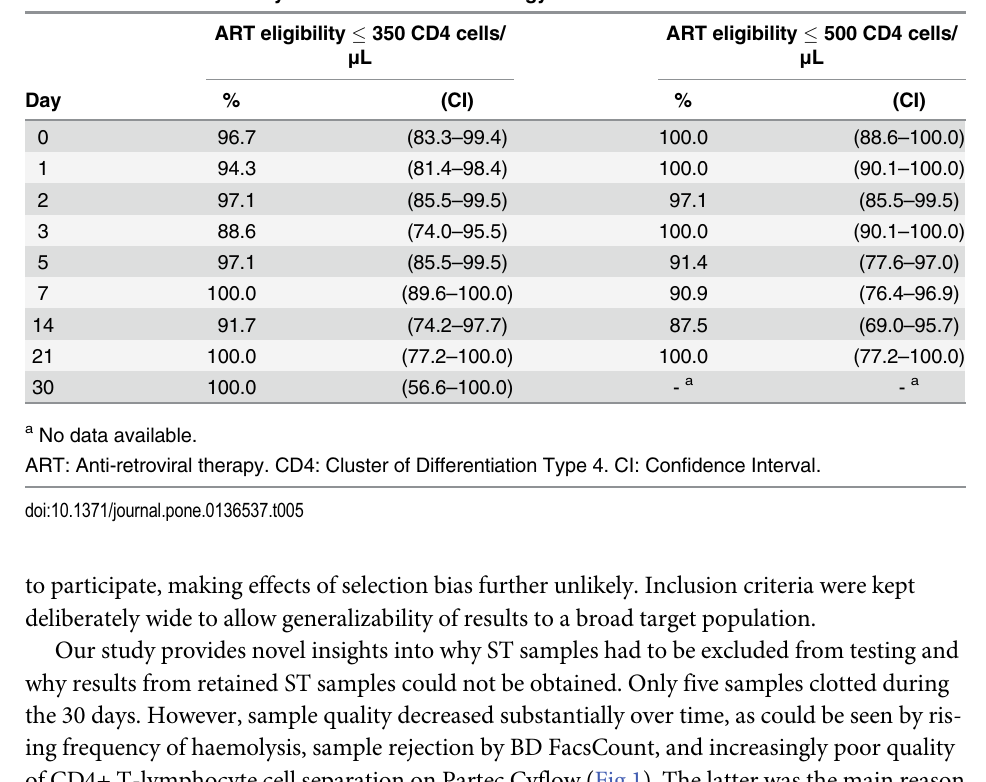
Table 5. Percentage of correctly classified BD Vacutainer CD4 Stabilization Tube sample results on Partec Cyflow for ART eligibility thresholds of 350 and 500 CD4 cells/ μ L over time with EDTA tube results on FacsCount at day 0 as reference